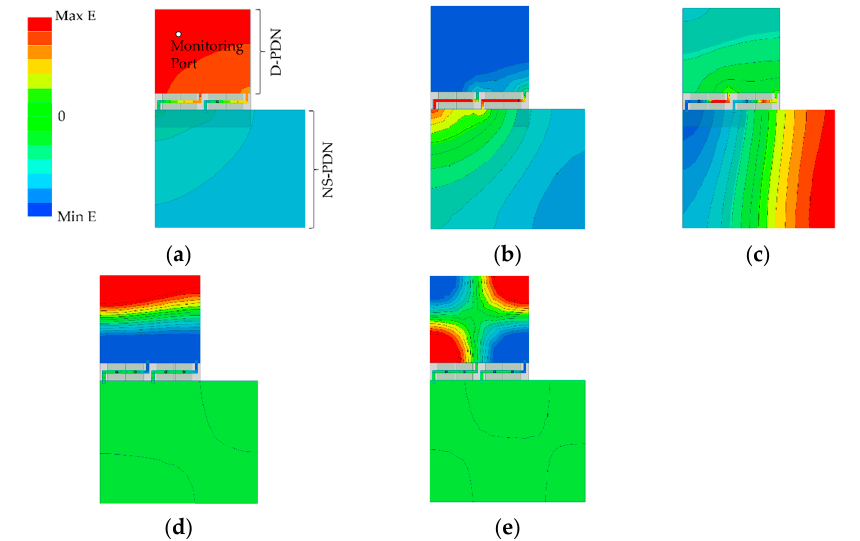
Figure 12. Electric field distributions of the resonant modes of ( a ) 1, ( b ) 2, ( c ) 3, ( d ) 4, and ( e ) 5.